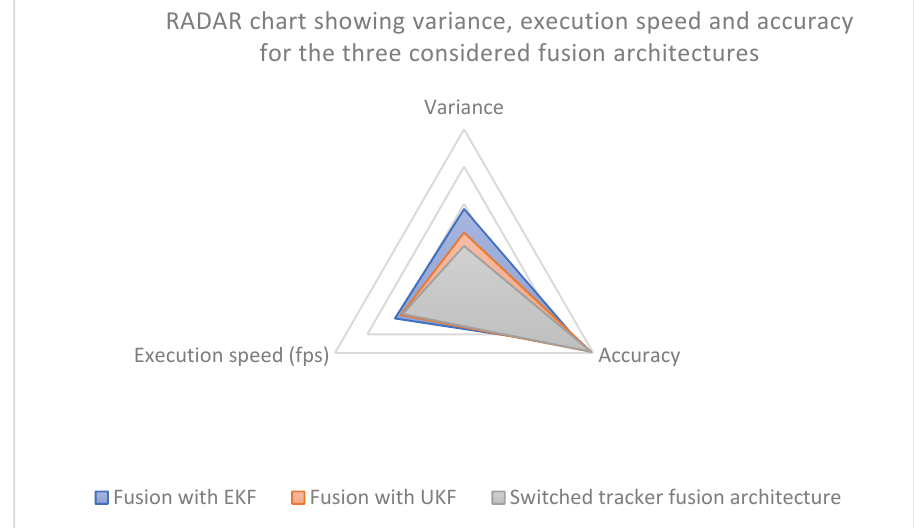
Figure 22. RADAR chart of the performance of the three considered fusion architectures based on variance, execution speed, and accuracy.